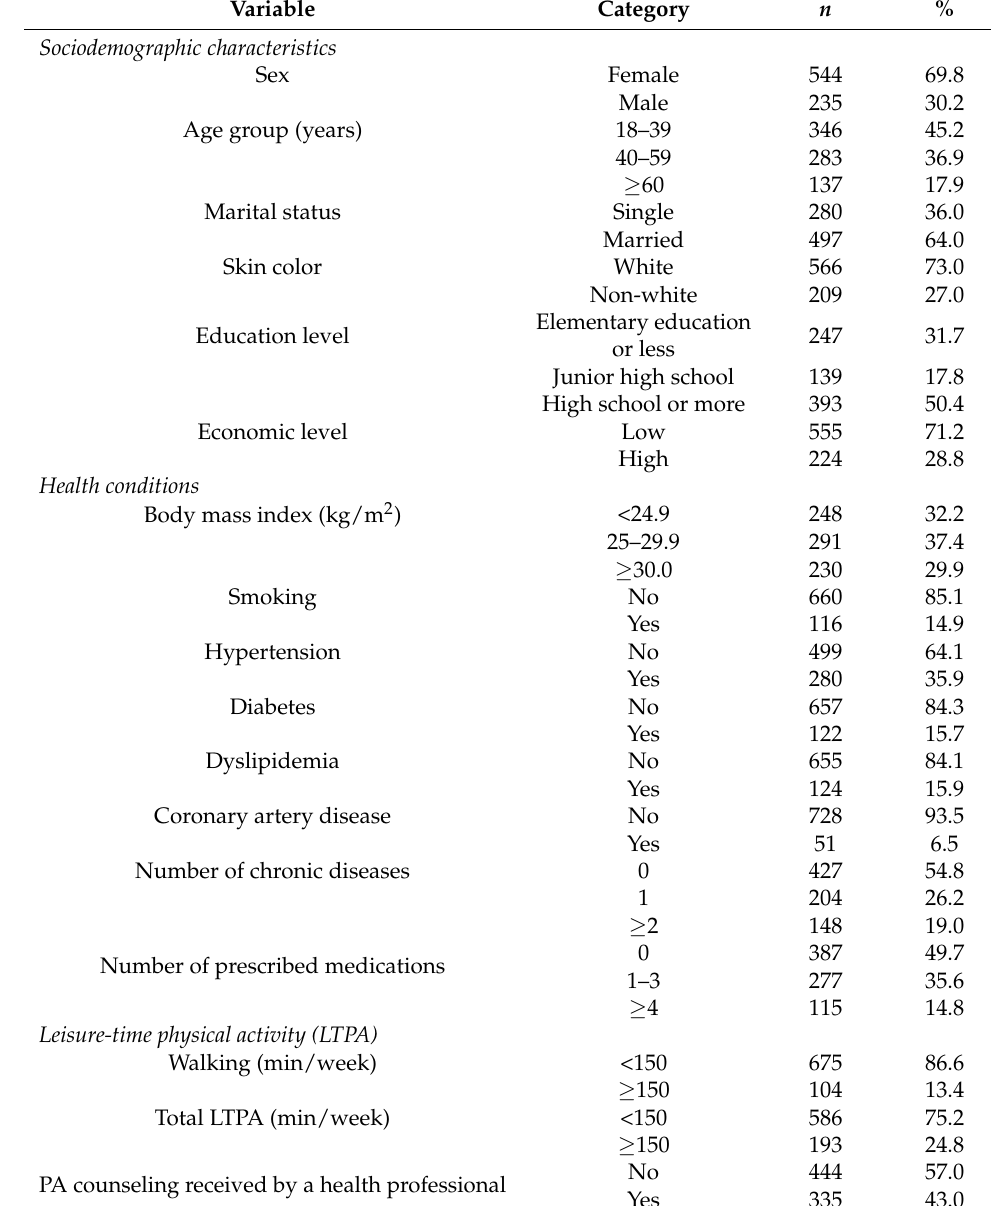
Table 2. Descriptive characteristics of adults in Primary Health Care units. S ã o Jos é dos Pinhais, Parana, Southern Brazil, 2019 ( n = 779). Variable Category n % Sociodemographic characteristics